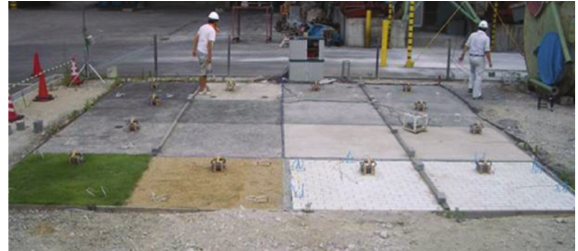
Figure 2: Photo of observation site (position as shown in Figure